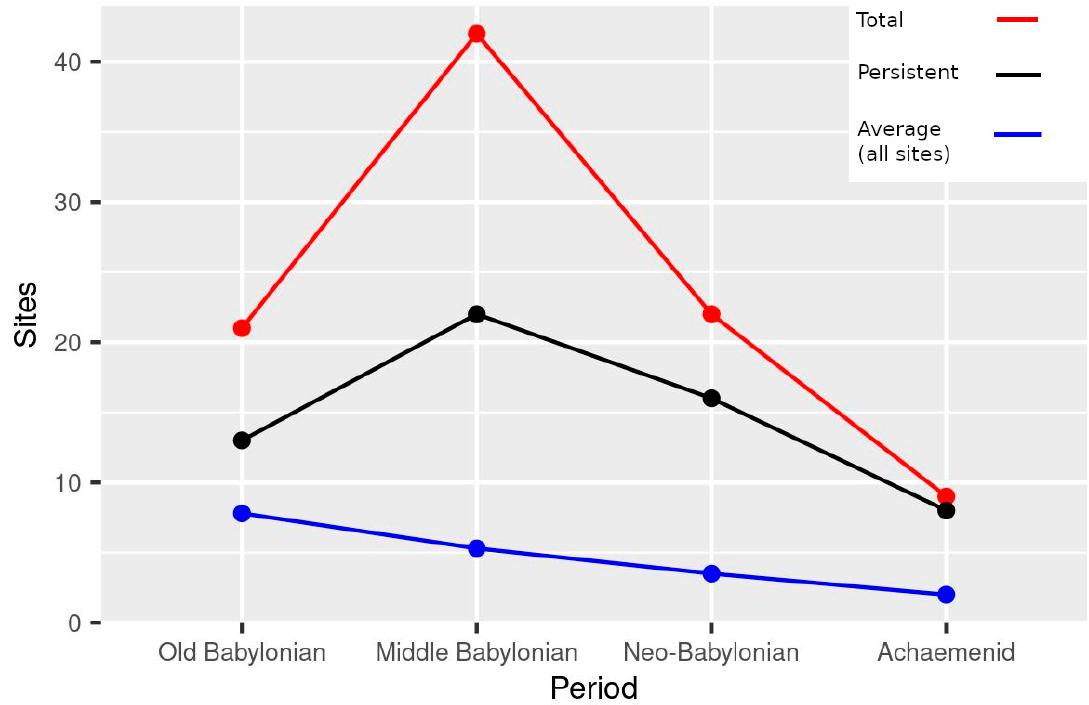
Figure 4. Number of sites surveyed by [27] includes total sites, those sites persisting between more than one site, and the average size in hectares of these